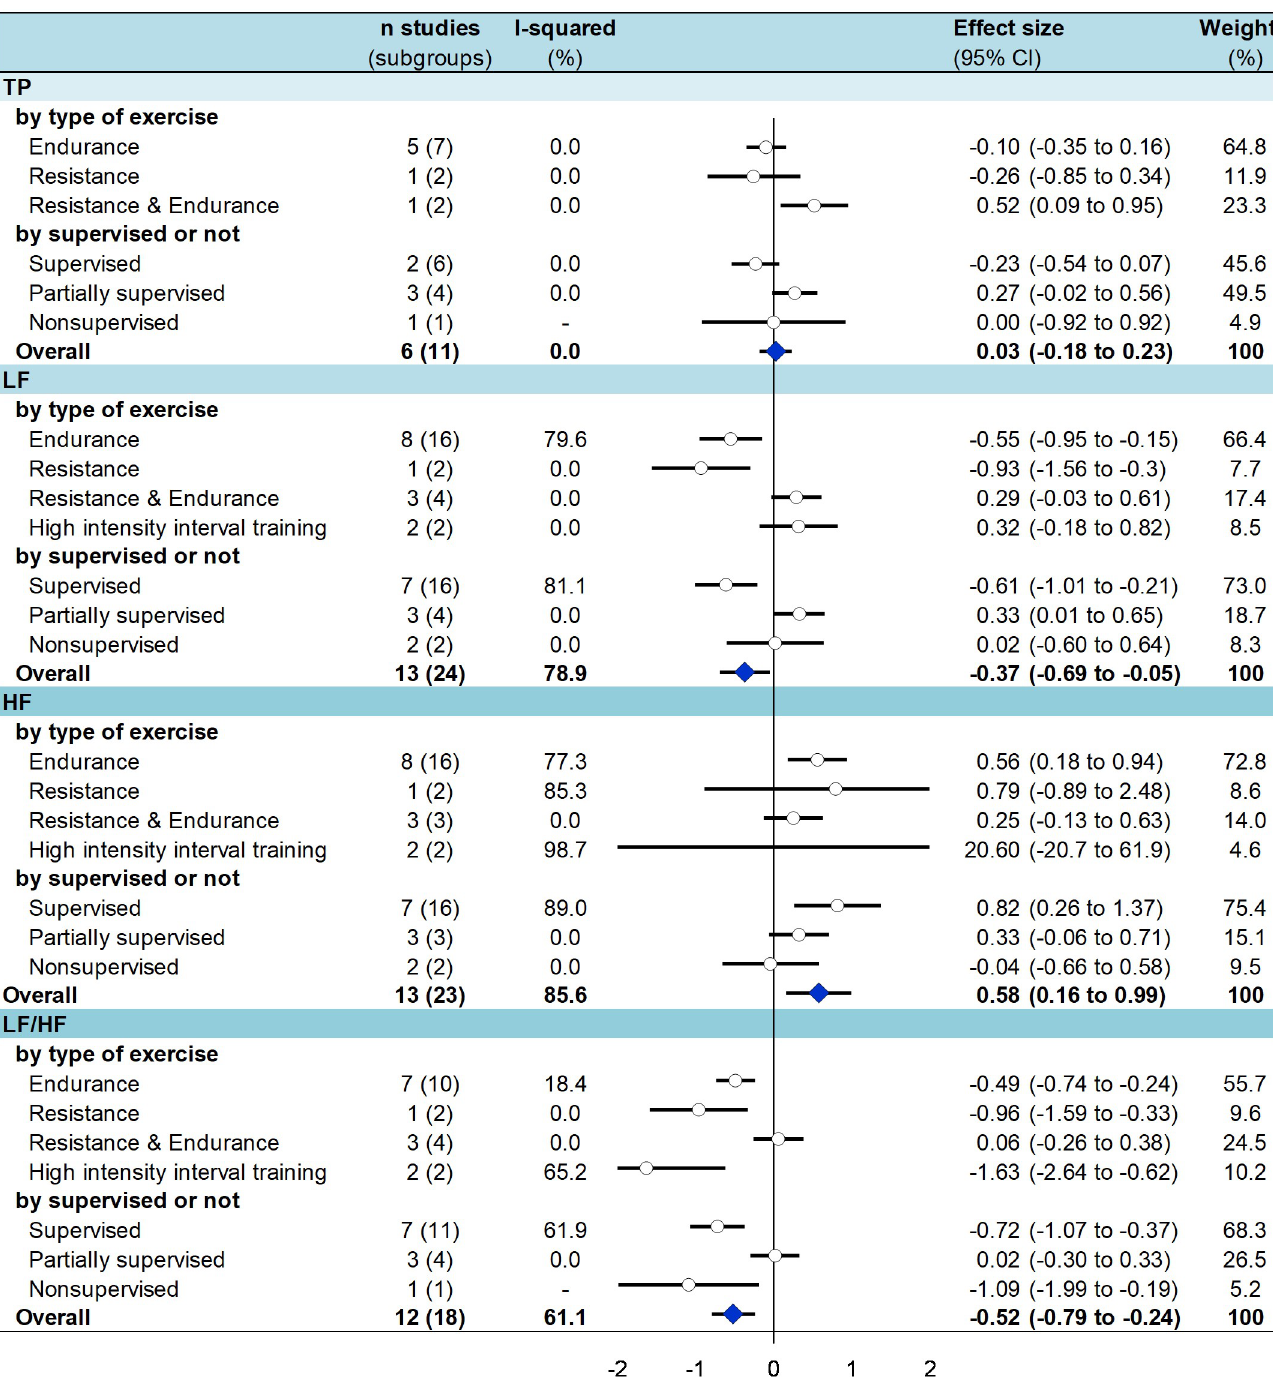
Fig 3. Summary of meta-analysis on the effect of exercise training on frequency domain parameters of HRV in T2DM patients—stratified by type of exercise and by type of supervision.